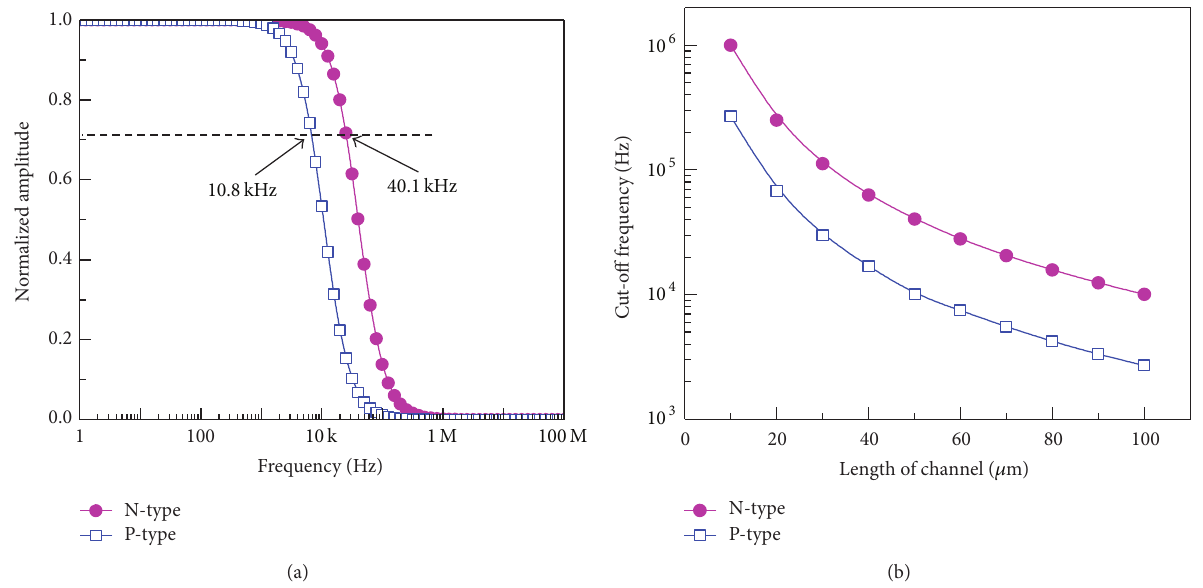
Figure 4: (a) Frequency response characteristics at 𝐿 = 50 𝜇 m. (b) Cut-off frequency versus length of